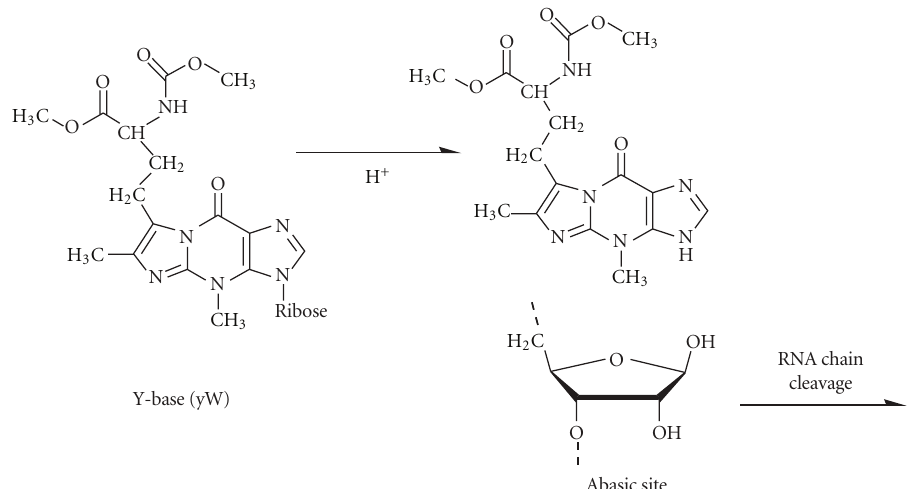
Figure 10: Depurination of wybutosine base (yW, Y-base) under mild acidic conditions. The formation of abasic site in RNA leads to the subsequent cleavage of the RNA